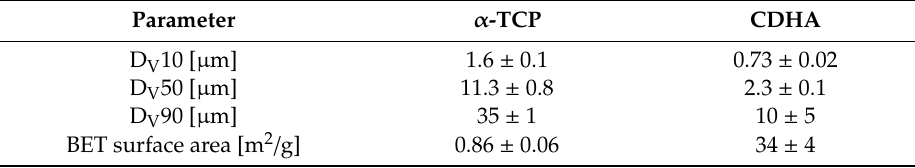
Figure 1. Particle size distribution of α –TCP and CDHA, determined by laser di ff raction using isopropyl alcohol as a lubricant; the means of three independently prepared measurements are presented; the error bars represent the standard deviation. Table 1. D V values obtained by laser di ff raction and BET surface areas of α –TCP and CDHA; the values are the means of three independent preparations, while for the laser di ff raction ten measurement runs were performed for each preparation; the errors represent the standard deviations of the three